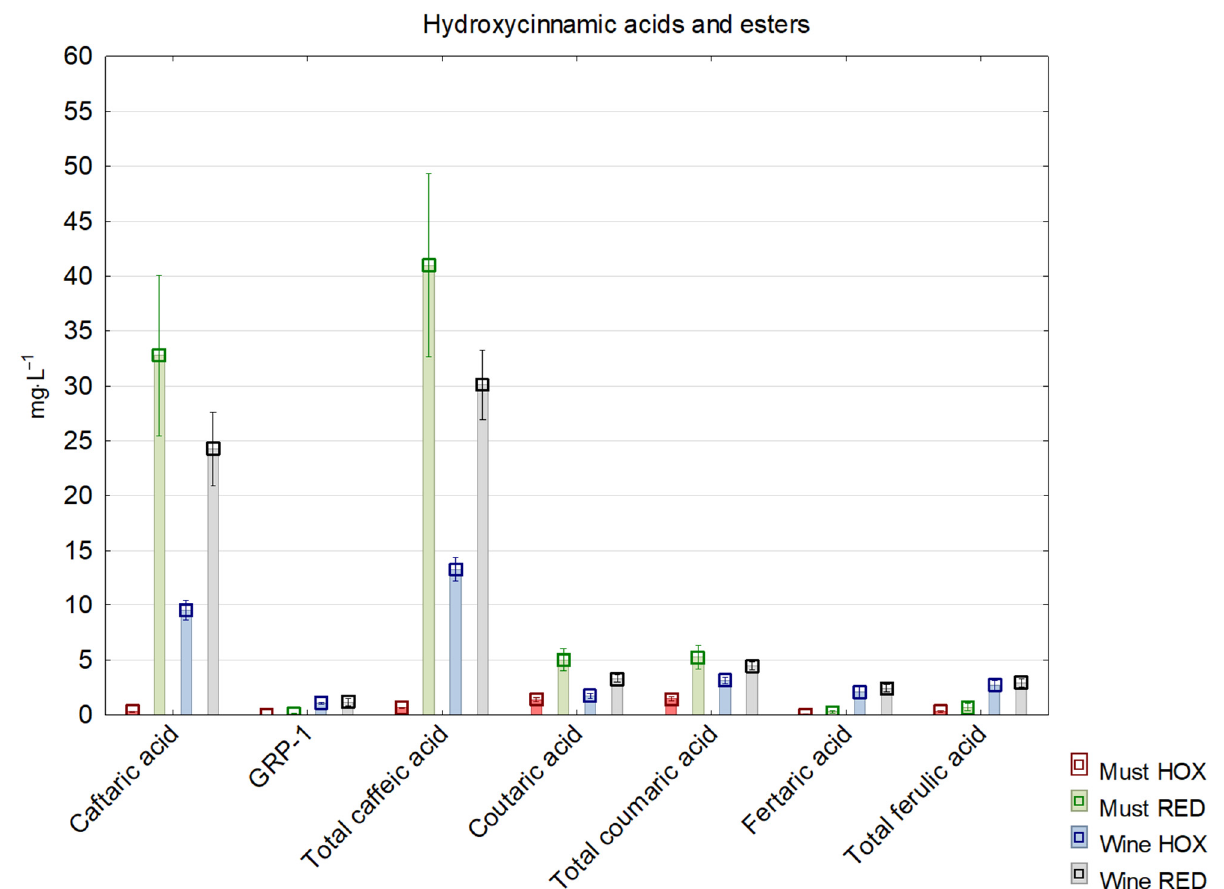
Figure 1. Concentration of selected hydroxycinnamic acids and esters in reductive and hyperoxidized musts and wines.